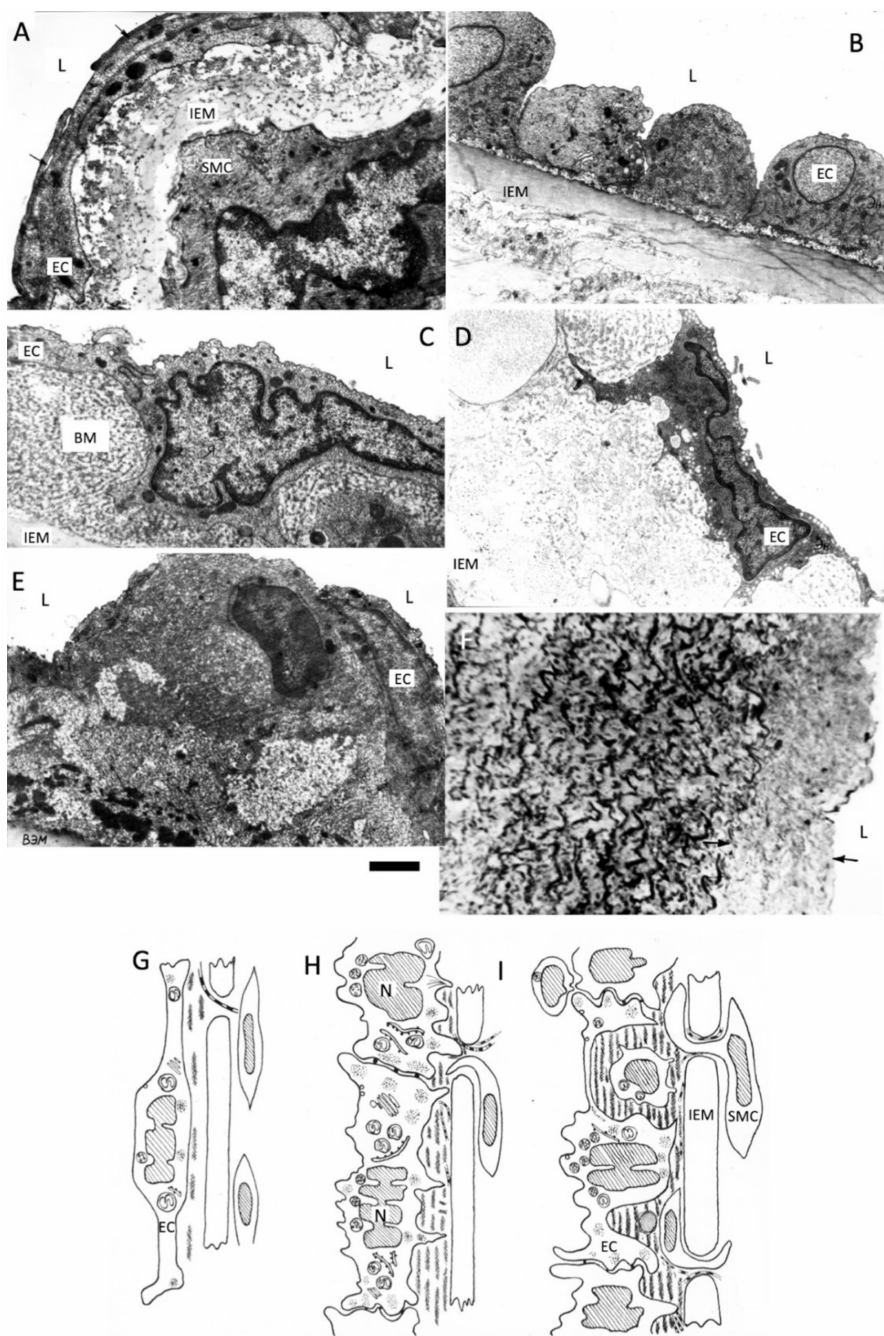
Figure 1. Accumulation of the basement membrane layers after multiple regeneration of endothelium. BM, basement membrane; L, Lumen of aorta; EC, endothelial cell; IEM, internal elastic membrane; SMC, smooth muscle cell. ( A ) Intima of the abdominal aorta in the normal rat; ( B ) Cross section of the abdominal rat aorta at the level of the regenerating endothelium cross sections of the spindle-like endothelial cells (EC) are shown; ( C ) Thick basement membrane (BM) is formed after several round of endothelial regeneration; ( D ) Thick basement membrane in old (24 years) rats; ( E ) Accumulation of extracellular matrix in the hypertensive rats (18 years old); ( F ) Semi-thin section of the intima (arrows) in the hypertensive rats (see E ); ( G – I ) Scheme shows gradual accumulation of the multilayered basement membrane and migration smooth muscle cells (SMC) in the area of turbulent blood flow in rat aorta. Images ( A – F ) are from our archives of already published data. Images ( G – I ) are adapted from Mironov et al. [53]. Scale bar: 1.5 µ